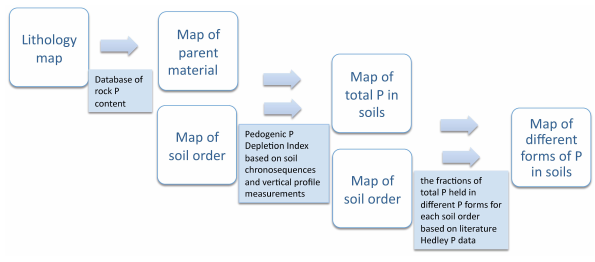
Fig. 1. Schematic steps and datasets utilized to generate soil P maps.